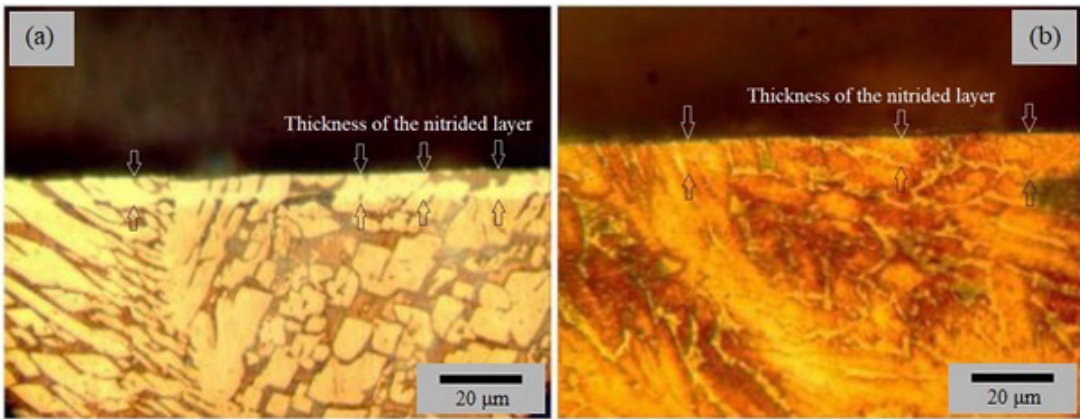
Figure 8. (a) Cross section view of the diffusion layer using CPN technique at 400°C. (b) Cross section view of the diffusion layer using CCPN at